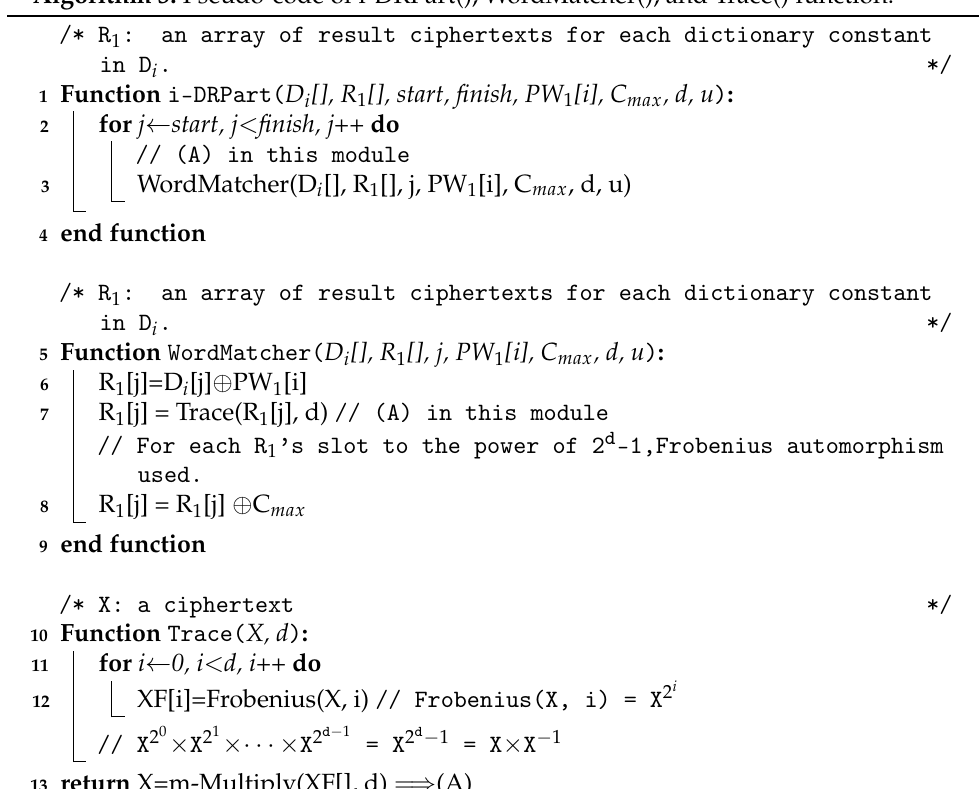
Algorithm 3: Pseudo-code of i-DRPart(), WordMatcher(), and Trace()